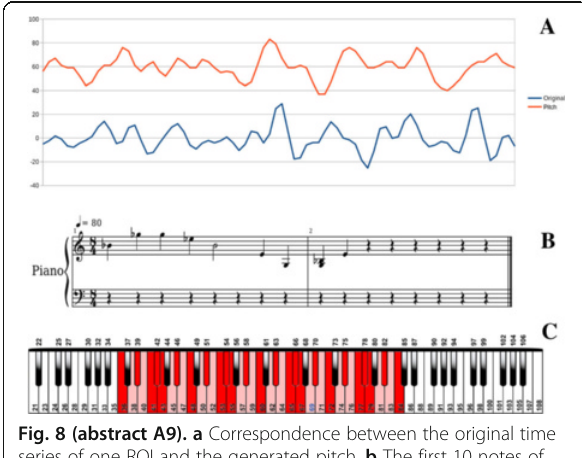
Fig. 8 (abstract A9). a Correspondence between the original time series of one ROI and the generated pitch. b The first 10 notes of the same ROI as sheet music. c All possible piano keys the brain can play, from 36 to 84 (in pink). We show in red all the possible tones for a C Minor-pentatonic scale, in the range of 36 to 84. In that case, the lowest key is 36. The keys that can be used are: 36, 39, 41, 42,